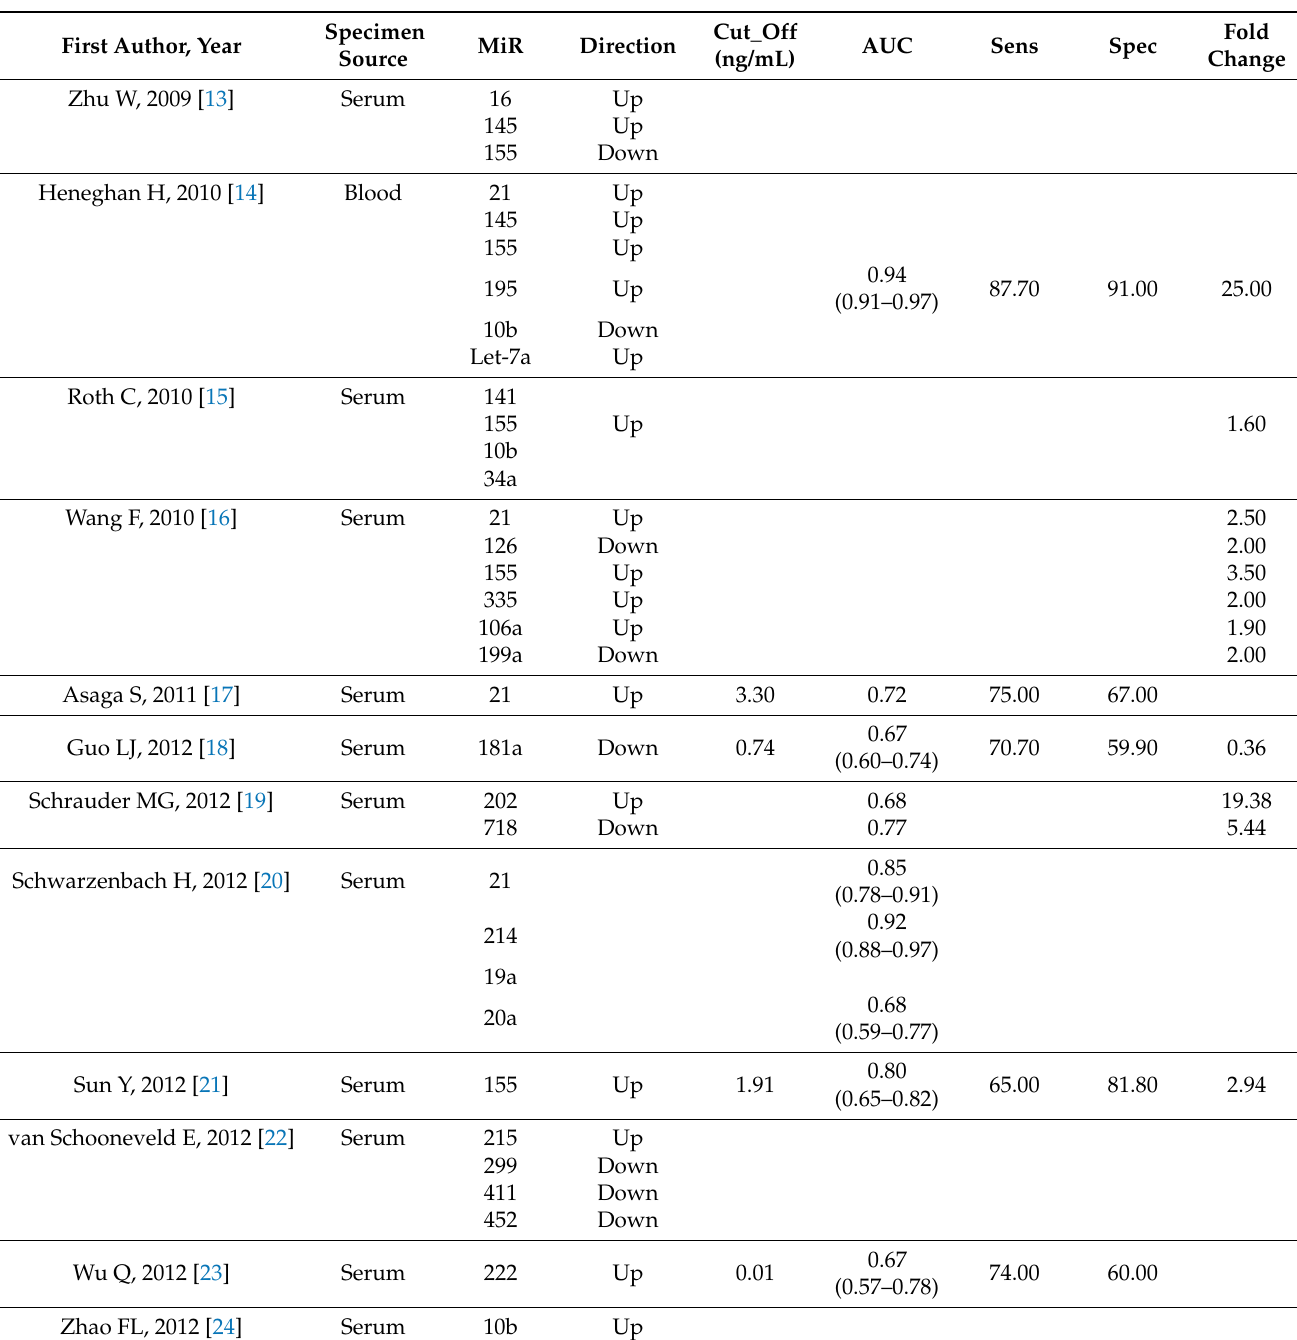
Table 2. Summary of the results of the studies included in the systematic review on the role of microRNA in breast cancer